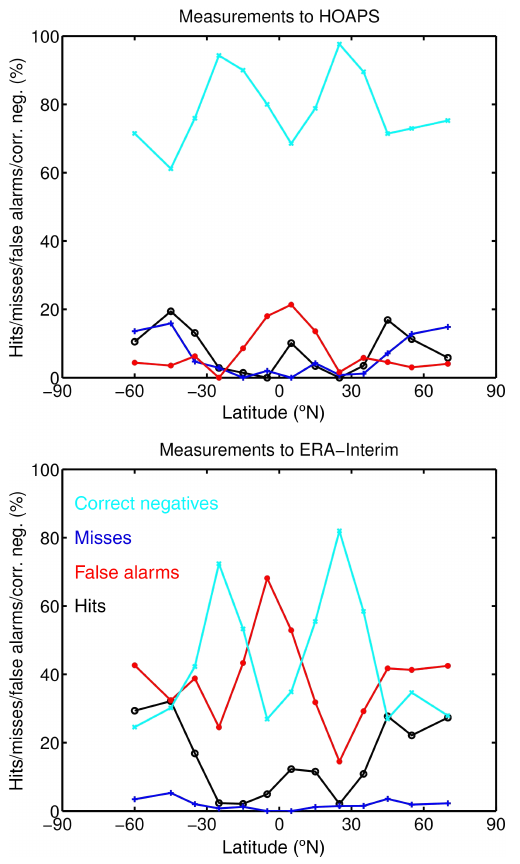
Figure 8. Hits, misses, false alarms and correct negatives of events for the period from 2005 to 2008 as a function of latitude (latitude belts are south of 50, 50–40, 40–30, 30–20, 20–10 and 10–0 ◦ S; 0–10, 10–20, 20–30, 30–40, 40–50, 50–60 and north of 60 ◦ N) for HOAPS (top) and ERA-Interim (bottom). A lower threshold is not set for ERA-Interim data.